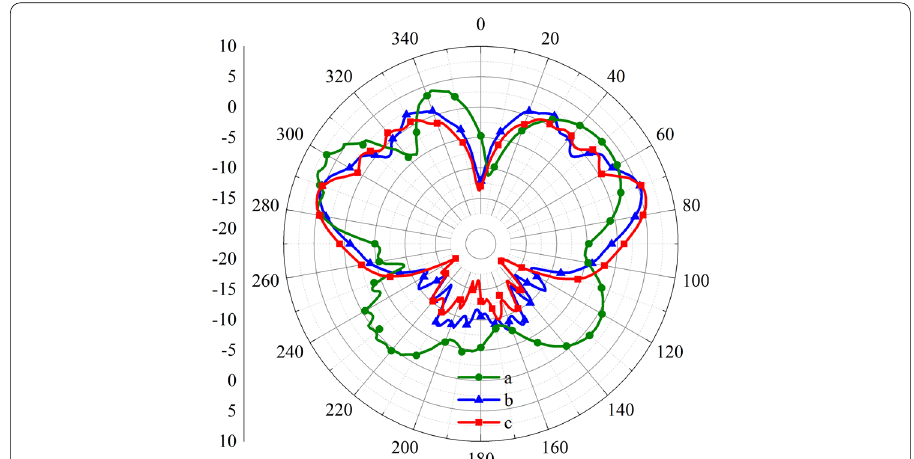
Fig. 13 The vertical radiation patterns with Phi 0° of the antenna being placed in different positions on = the roof at 2.64 GHz. Line a is the radiation pattern of antenna installed in the corner of the roof. Line b is the radiation pattern of antenna installed in the center of the roof. Line c is the radiation pattern of antenna installed at the rear edge of the roof